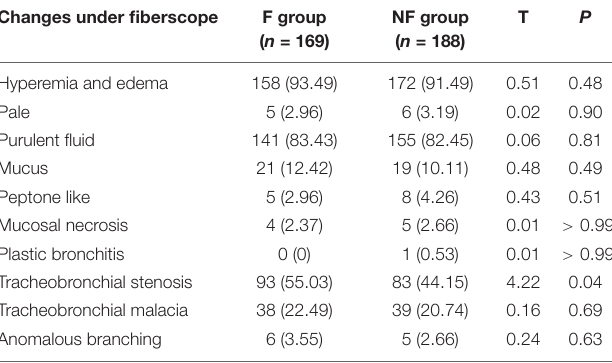
TABLE 8 | Comparison of the pulmonary fibroscopic findings between